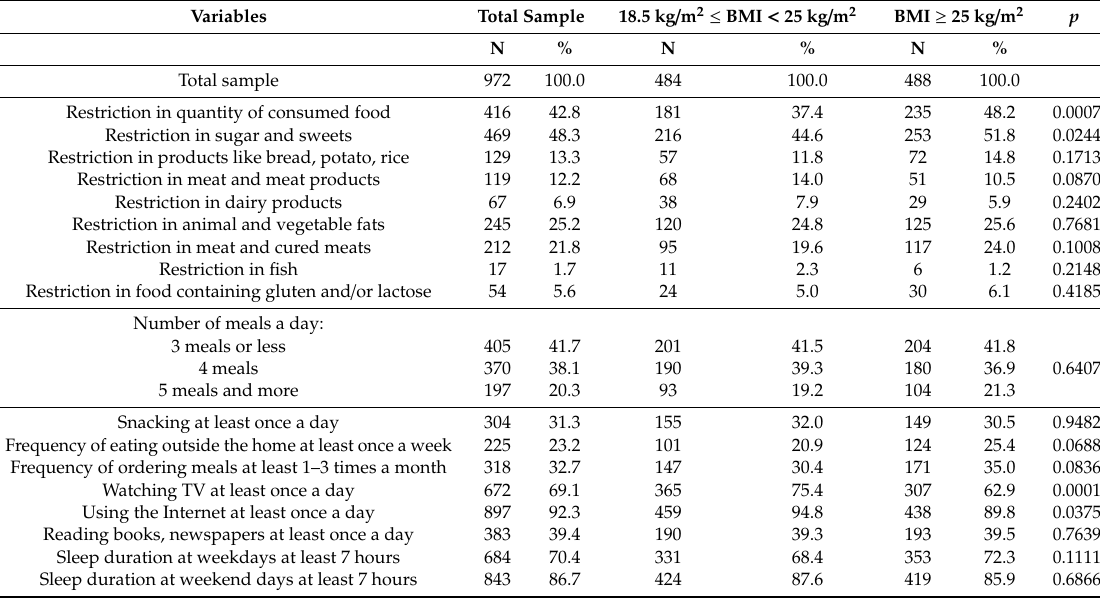
Table 2. Lifestyle characteristics of the study